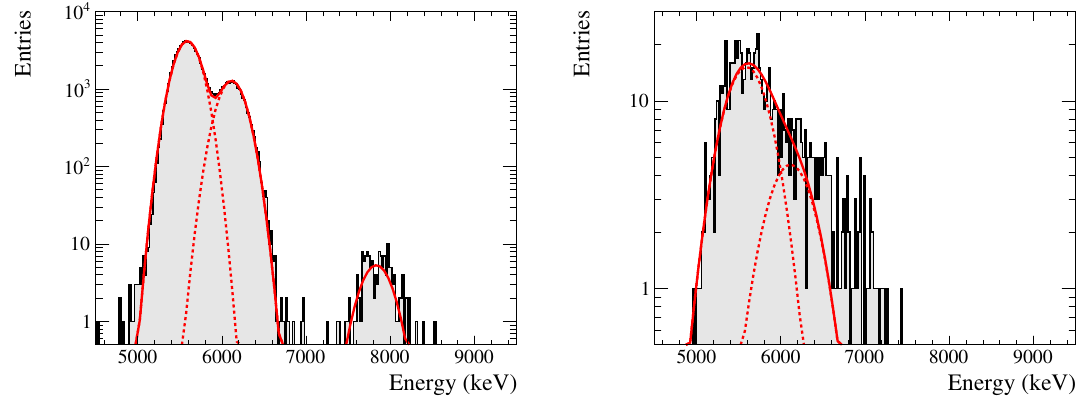
Figure 6 . Energy distribution for (cid:12)ducial alpha candidate events during run periods A3 (left panel) and A1 (right panel). A triple gaussian (cid:12)t is superimposed to the A3 histogram to describe the 222 Rn (5590 keV), 218 Po (6115 keV) and 214 Po (7834 keV) populations. Only the 222 Rn and 218 Po yields are (cid:12)tted in the A1 histogram.